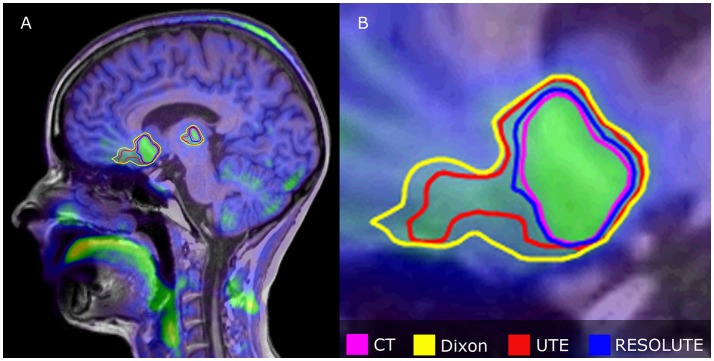
Relative differences in tumor delineation by attenuation correction methods in multifocal Astrocytoma grade II patient overlaid onto FET PETCT fused with T1w MPRAGE. (A) Shows sagittal orientation, (B) Shows expanded anterior tumor section. RESOLUTE has the best overlap with CT-AC, while Dixon and UTE is significantly overestimated, because of difficulties in defining AC in the skull base and nasal cavity. BTV (mL)/Jaccard Index relative to CT (%) was for CT: 44, Dixon: 75/0.59, UTE: 61/0.72, RESOLUTE: 48/0.89.